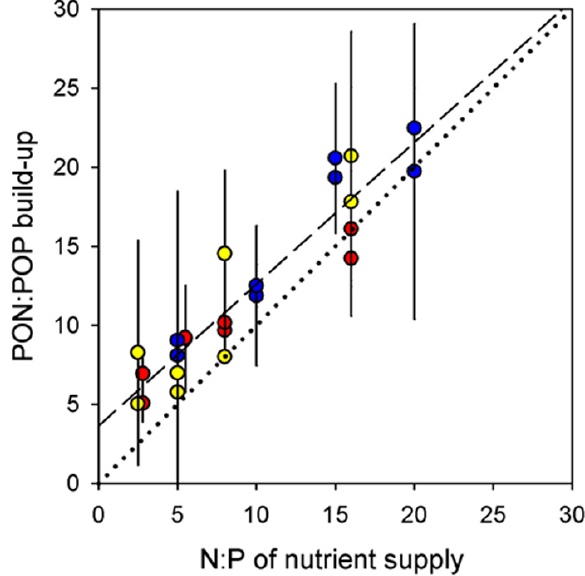
Fig. 6. Positive linear correlation (dashed line: y = 0 . 90( ± 0.07) x + 3 . 64( ± 0.08), r 2 = 0 . 875, p < 0 . 0001) be- tween N : P of nutrient supply and the PON : POP of produced biomass until day one and two after DIN limitation in the PU (yellow), ETNA (blue) and WA (red) experiment. Dotted line indicates PON : POP build-up equal to N : P supply. Values are treatment means and the vertical error bars denote the standard deviation of replicates within each N : P